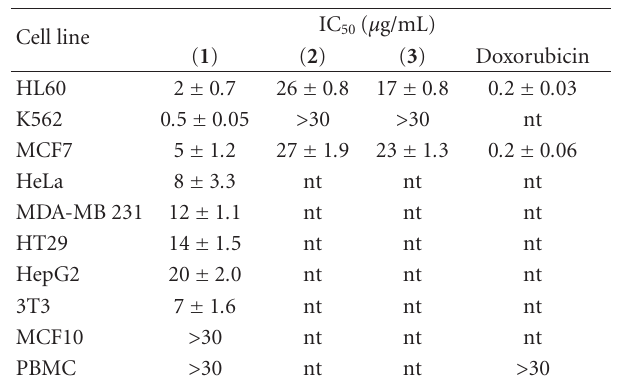
Table 2: The IC 50 values of isolated compounds towards various cell lines.